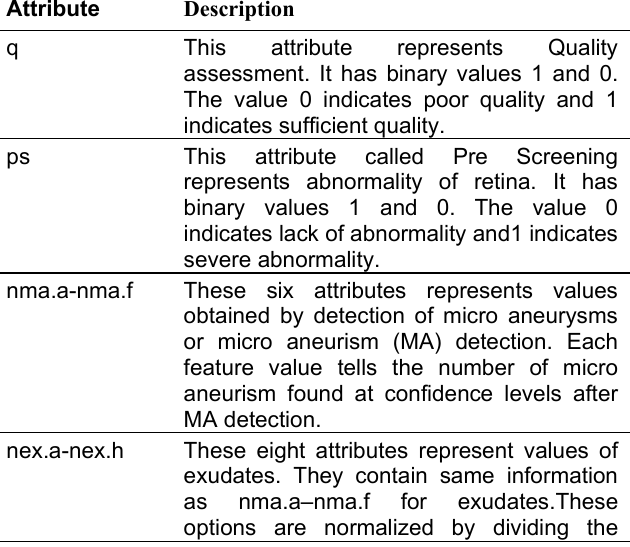
Table 1. Attributes in the